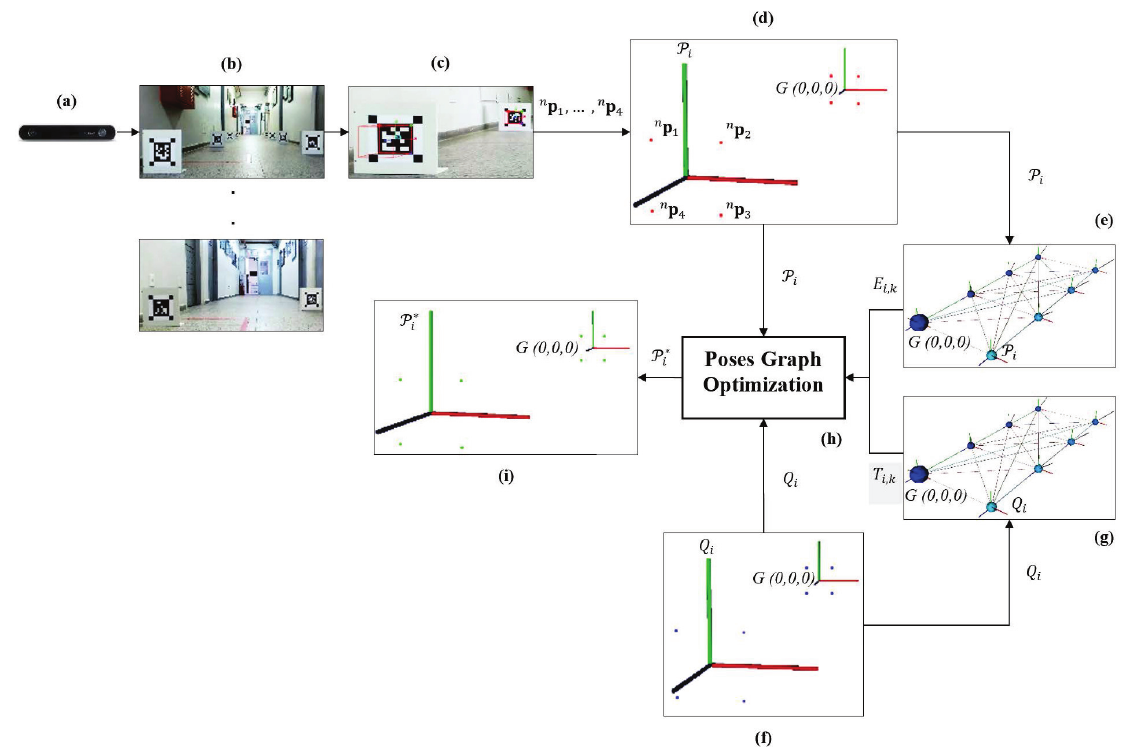
Figure 1. Diagram of steps for the marker map’s construction. ( a ) The first step is to calibrate a camera. ( b ) Then, place a set of smart markers in a scene and capture a video. ( c ) Detect and get the points of each marker. Compute the markers’ poses using the points ( d ), and the relative transforms between all pairs of markers’ poses ( e ). ( f ) Measure the markers’ points and poses using the PMS unit of each marker. ( g ) Compute the relative transforms between all pairs of measured markers’ poses. ( h ) Create a graph of markers’ poses and optimize it. ( i ) Finally, after optimization save the optimal markers points and poses to use in an online camera localization process.